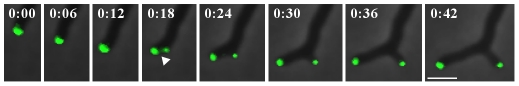
Example of branching at almost zero distance from the tip.The model indicates that this is due to tip-focus splitting events (arrow) where  is greater than . Time in hours∶minutes. Scale bar: .